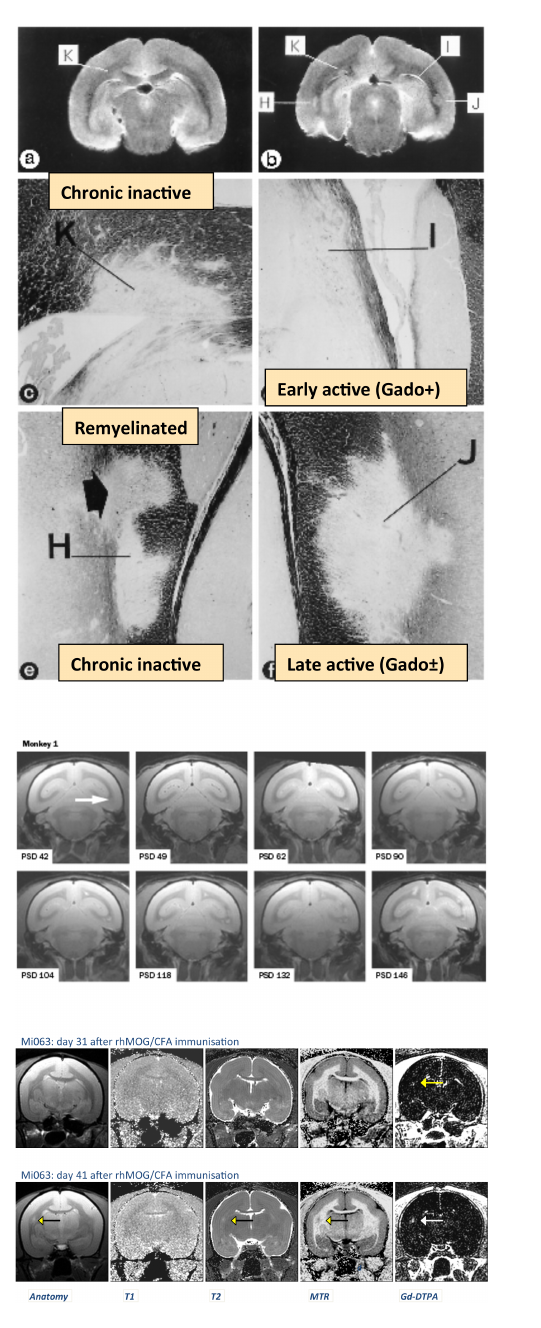
Figure 1. Magnetic resonance imaging of brain lesions in marmoset experimental autoimmune encephalomyelitis (EAE). (a) Marmosets were immunized with human myelin in CFA. The depicted case was sacrificed at the height of the disease with serious clinical deficits. The brain was carefully removed, briefly fixed with 4% buffered formalin and MRI-scanned (T2-weighted, 4.7T) to detect the spatial distribution of lesions. Lesions are indicated with capitals (a, b) . Stainings of individual lesions with Klüver–Barrera for myelin are depicted in (c) – (f) . (b) The brain of a single marmoset in which EAE was induced with rhMOG/CFA was longitudinally scanned (T2-weighted, 4.7T) to illustrate the dissemination of lesion formation in time and space. In the insert the time after immunization (psd: post-sensitization day) is given. (c) Different imaging modalities were developed for in vivo characterization of lesions: T2-weighted images for high contrast anatomy, T1 and T2 relaxation time (RT) images to quantify changes in the signal intensities associated brain injury and inflammation, magnetic transfer ratio (MTR) images which provide essentially the same information and finally images created by subtracting T1-RT images generated before and 10min after infusion of the paramagnetic contrast agent gadolinium-DTPA. This modality visualizes lesions with a leaky blood–brain barrier (BBB) caused by inflammation. The message of this figure is that a lesion first visible as a small region of BBB leakage appears 10 days later as a large hyperintense region in the T2 and MTR